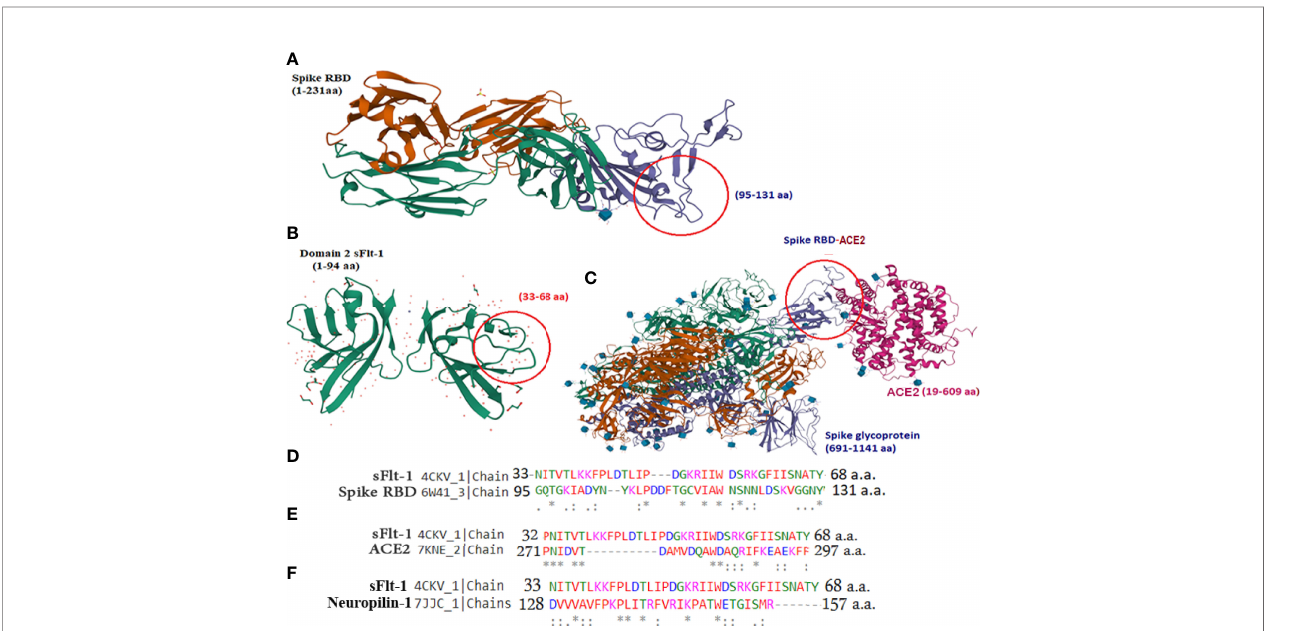
(GLU137) of sFlt-1 and amino group atom of LEU517 of spike RBD, and an oxygen atom (GLU137) of sFlt-1 with the hydrogen atom of THR430 of spike RBD recording the lowest binding energy of -5.03 kcal/mol at a distance of 1.89 Å and 1.87 Å respectively, as shown in Figures 2F, G . Also, other putative amino acids of sFlt-1 are Pro134: O, Arg133:O, Gly132:O, Met138:O, and Gly139:OH involved in binding spike RBD with Asp427:HN, Phe377:HN, Thr430:HN, Thr430:HG1, and Leu517:HN respectively. 3D visualization of spike RBD and sFlt-1 interactions with hydrophobicity binding